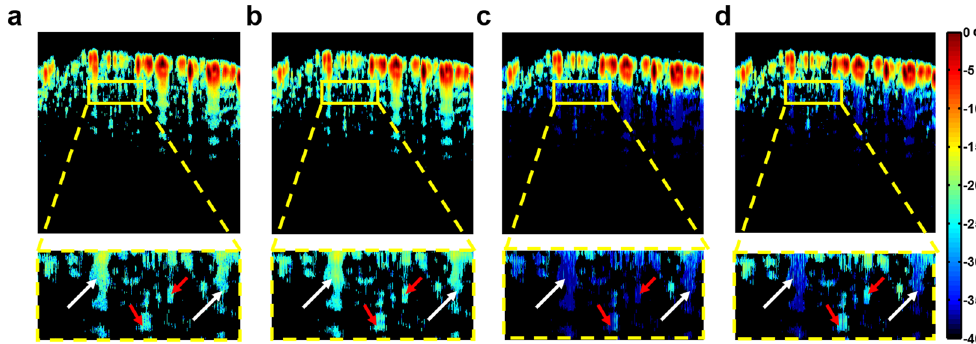
Figure 5. ( a ) Raw signal on masked area. ( b ) Dictionary coded signal overlaid on true signal area. ( c ) Maximum windowed signal overlaid on true signal area. ( d ) Correlation windowed signal overlaid on true signal area. White arrows denote reverberant echoes, and red arrows denote true signals of smaller amplitude. As shown in the zoomed insets, the signals of smaller amplitude are retained in the correlation-windowed signal ( d ), compared to ( c ).